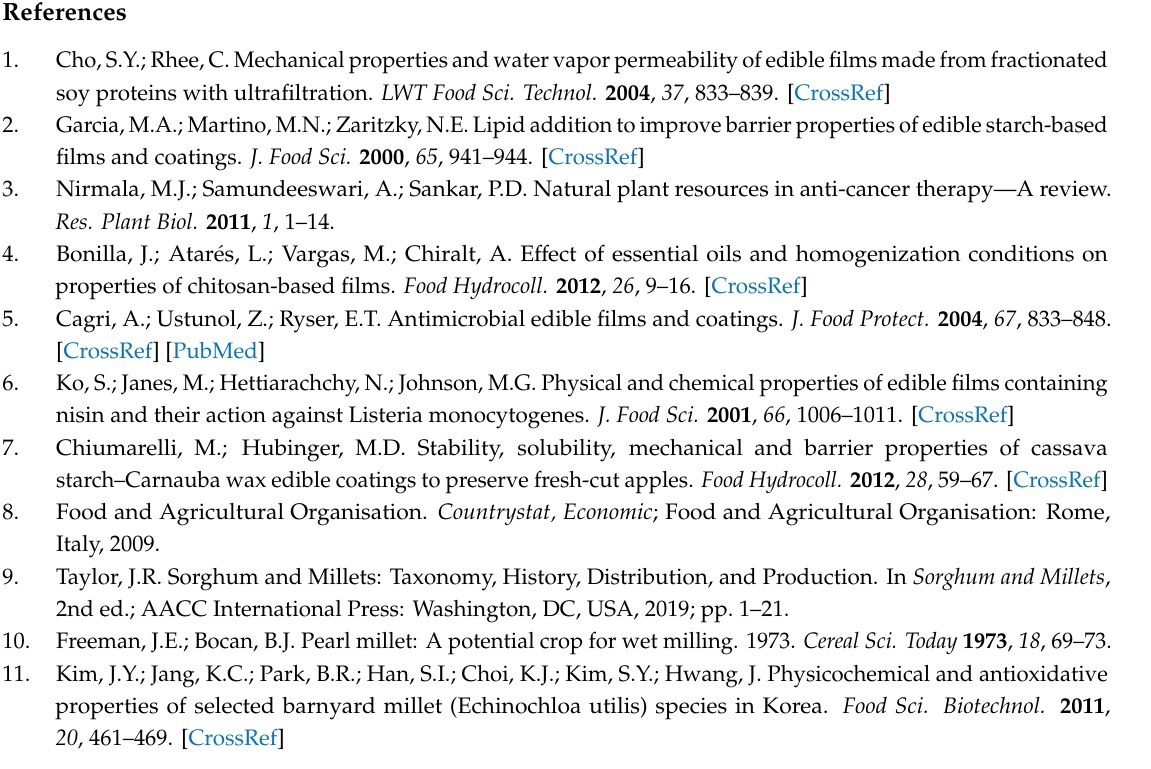
Figure S1: MS spectrum of Eugenol; Figure S2: MS spectrum of Eugenol acetate; Figure S3: MS spectrum of caryophyllene; Figure S4: MS spectrum of humulene; Figure S5: MS spectrum of caryophyllene